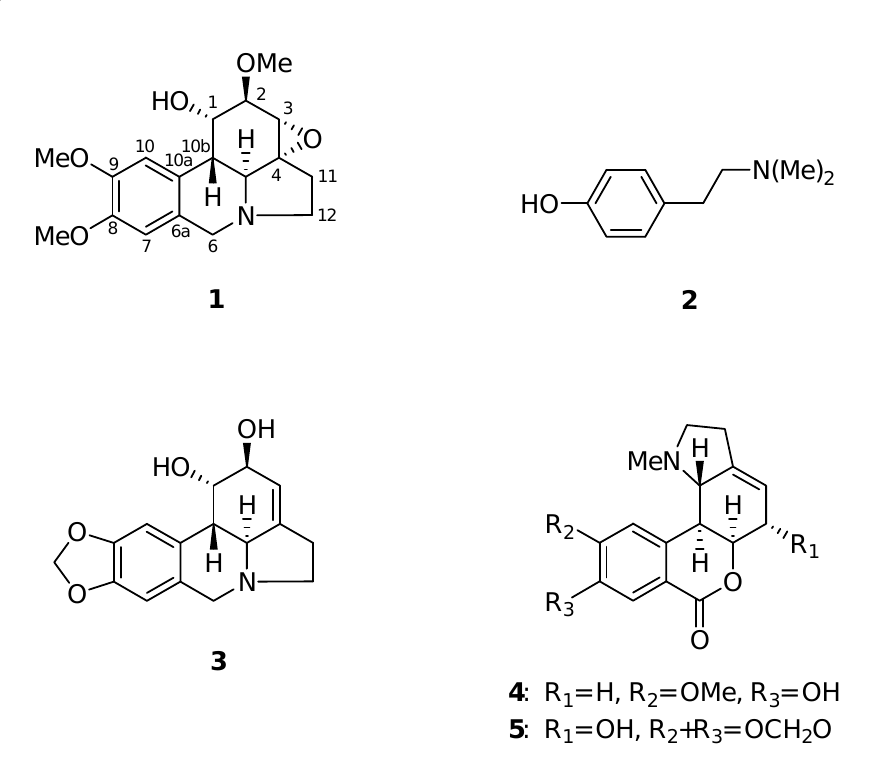
Figure 1. Chemical structures of the alkaloids isolated from Galanthus elwesii